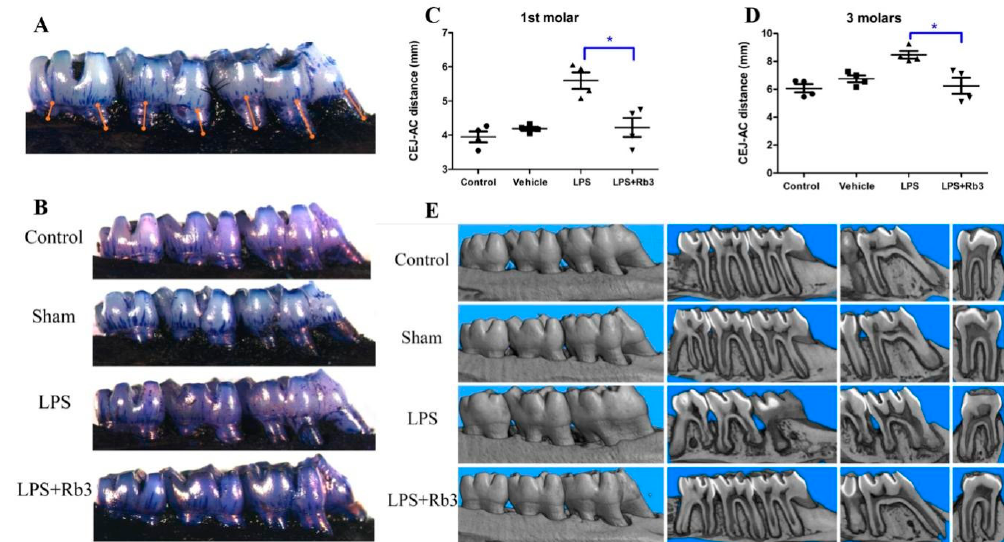
Figure 6. Rb3 treatment ameliorates alveolar bone resorption in rats. ( A ) Digital image indicating 7 measurement sites of the right half maxilla from the palatal aspect. ( B ) Stereomicroscopic images of the right jaw from palatal direction, CEJ and AC were delineated by methylene blue. ( C ) Statistical analysis of ABL for the first molar was presented in scatter graph. ( D ) Statistical analysis of ABL for all three molars was presented in scatter graph. ( E ) Micro-CT 3D reconstruction images and cross-section images of rats. Results were presented as means ± SE (n = 4 rats/group). * p < 0.05 versus LPS group. ABL, alveolar bone loss; CEJ, cemento-enamel junction; AC, alveolar bone; SE, standard